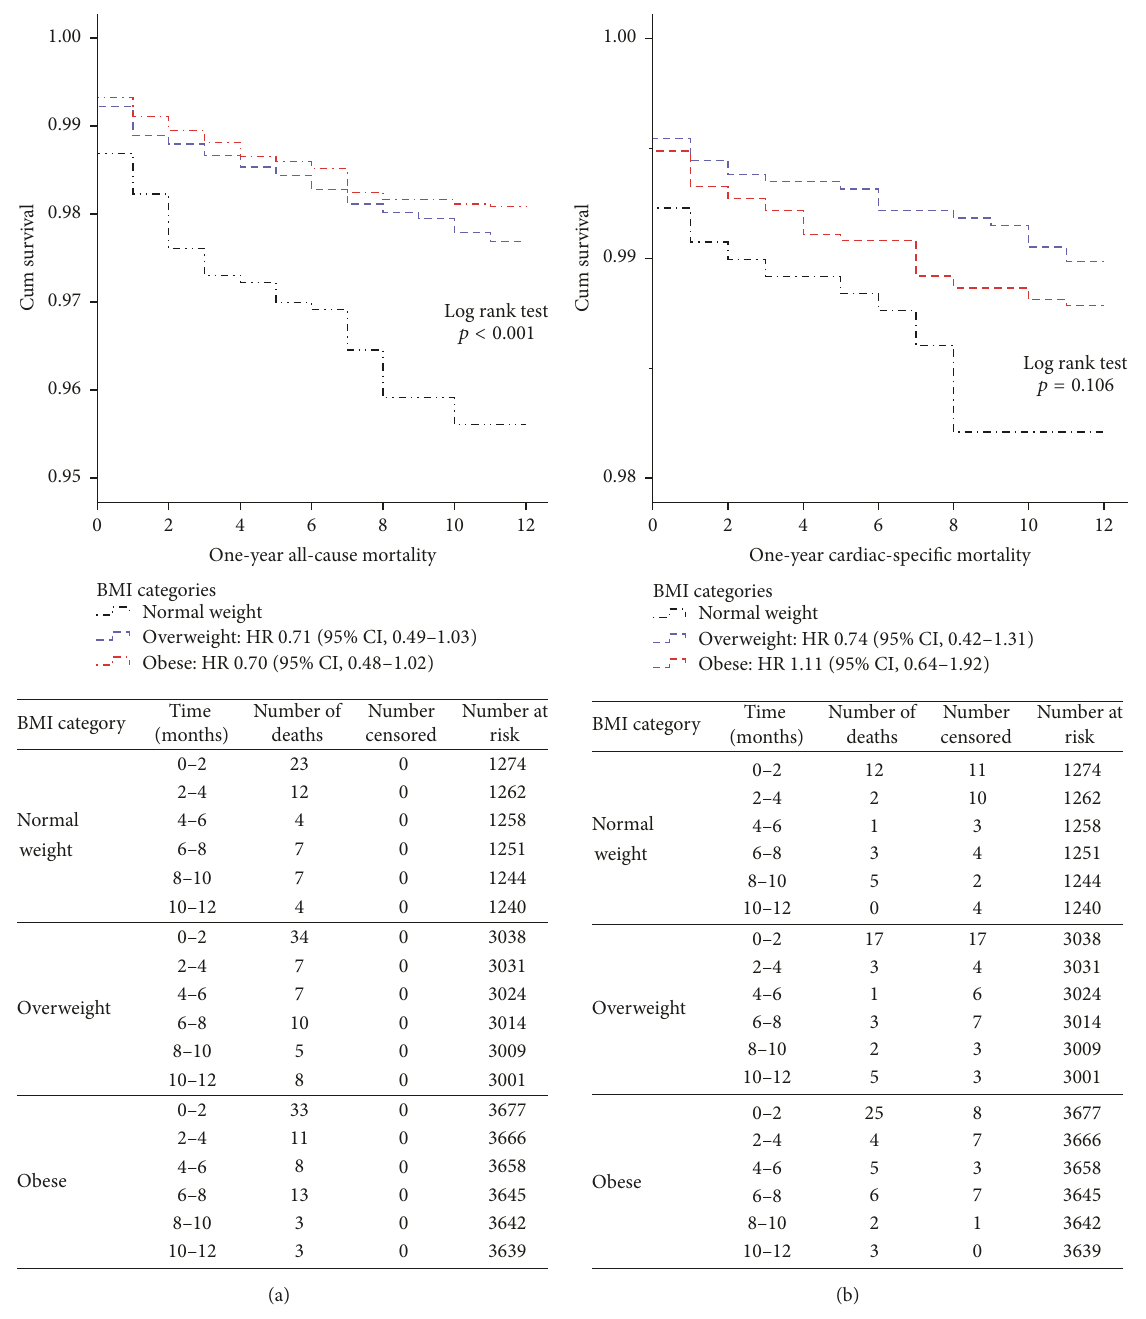
Figure 2: (a) Unadjusted Kaplan Meier and 1-year all-cause mortality in patients undergoing coronary angiography by BMI. (b) Unadjusted Kaplan Meier and 1-year cardiac-specific mortality in patients undergoing coronary angiography by BMI.